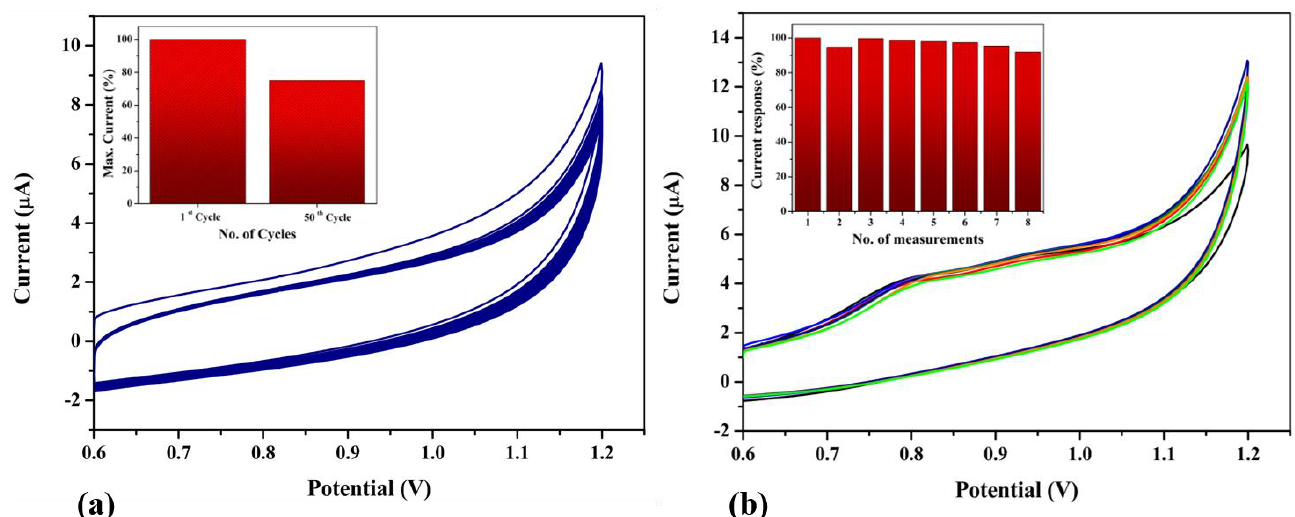
Figure 13. ( a ) CVs were recorded using an Ag-NPs/GCE for continues 50 cycles in 0.1 M PBS at a scan rate of 50 mV/s. (inset: Bar plot shows the changes in current during the 1st cycle and 50th cycles). ( b ) CVs of 100 µ M NIC detection in 0.1 M PBS for 8 times on an Ag-NPs/GCE at a scan rate of 50 mV/s. (inset: Bar diagram shows the changes in peak currents for 100 µ M NIC on a same Ag-NPs/GCE).